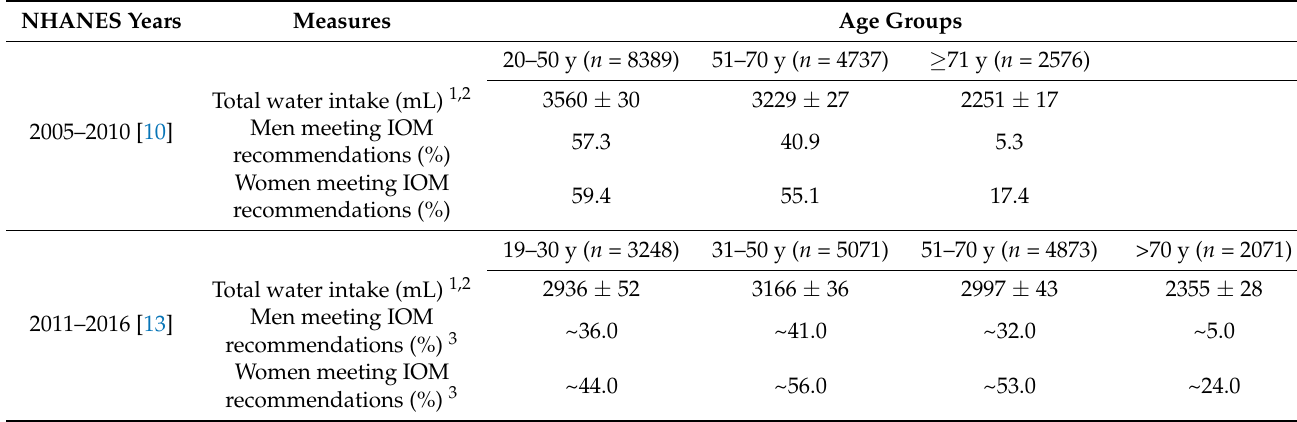
Table 1. Total water intake and percentage of individuals meeting IOM adequate intake recommendations for water by age group from recent NHANES